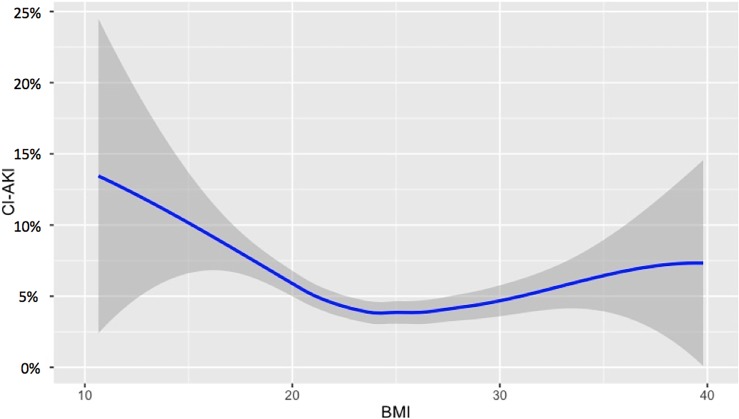
Smooth spline plots of BMIs and CI-AKI incidence rates.The smooth spline is shown as a blue line and the gray area represents the 95% confidence intervals. BMI, body mass index; CI-AKI, contrast-induced acute kidney injury.